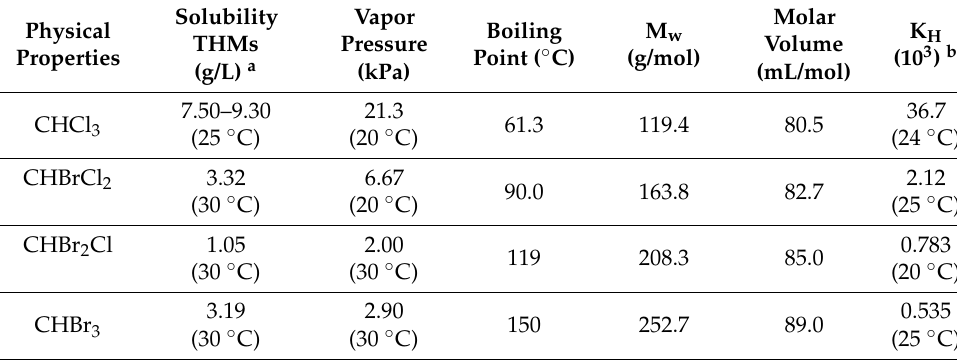
Table 2. Physical properties of trihalomethanes